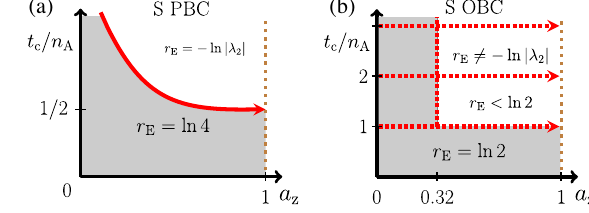
FIG. 11. Phase diagram of r